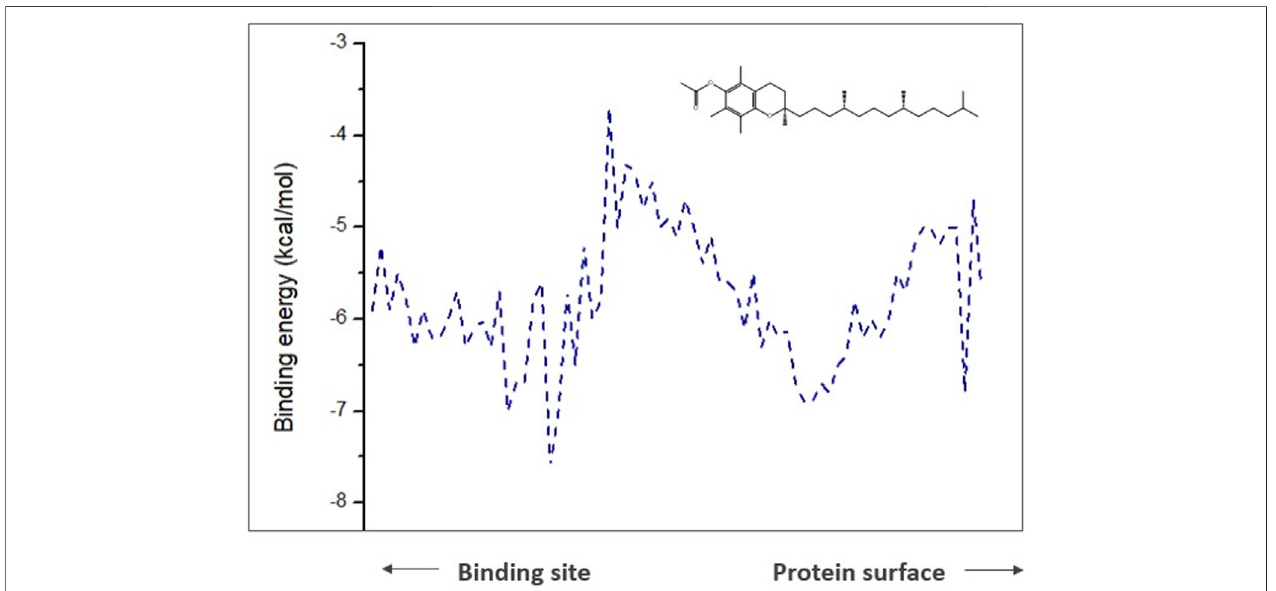
FIGURE 8 | Representation of the trajectory binding energies and ray size for α -tocopherol acetate in tunnel 2.